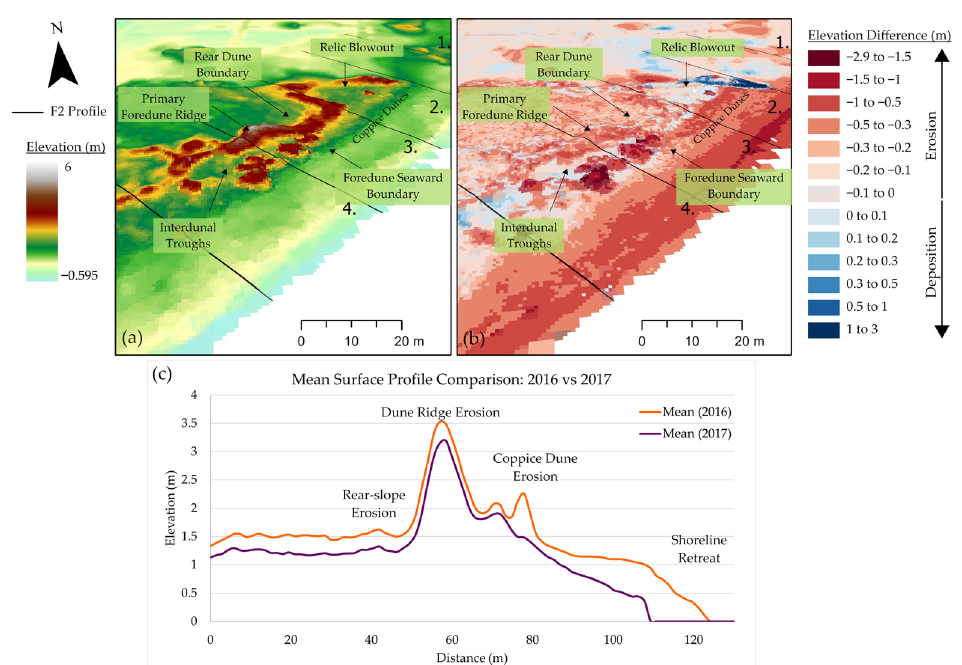
Figure 10. 3D models of Follett’s Site 2. ( a ) A 3D model of 2016 USACE’s edited topobathy lidar- derived DEM with 4 labeled shore perpendicular transects used to compare pre- and post- storm beach profiles within Follett’s Site 2; ( b ) DEM Difference Map was created using USACE’s 2016 and BEG’s 2017 surface elevation data draped over the 2016 elevation model to show changes to the site after Harvey; ( c ) The 2016 and 2017 mean profiles for transect 4 overlayed for